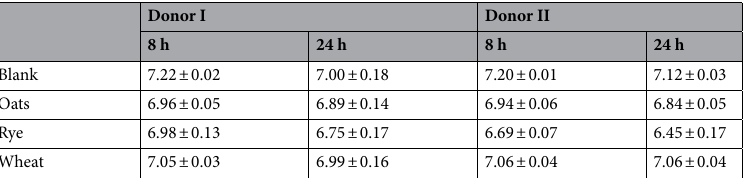
Table 2. Changes in pH during the fermentation experiments (mean ± s.d.). Blank indicates samples without substrate, and oats, rye and wheat indicate samples with fermentation